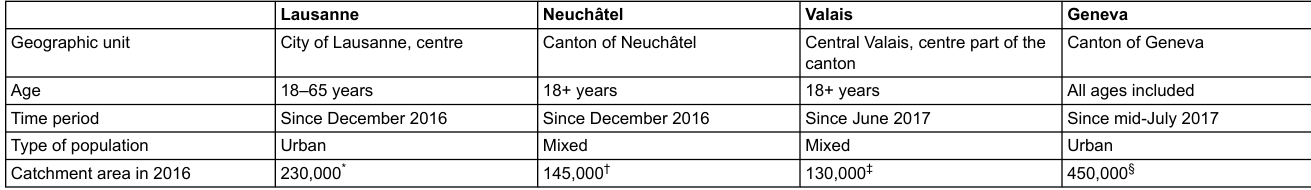
Table 1: Characteristics of the four